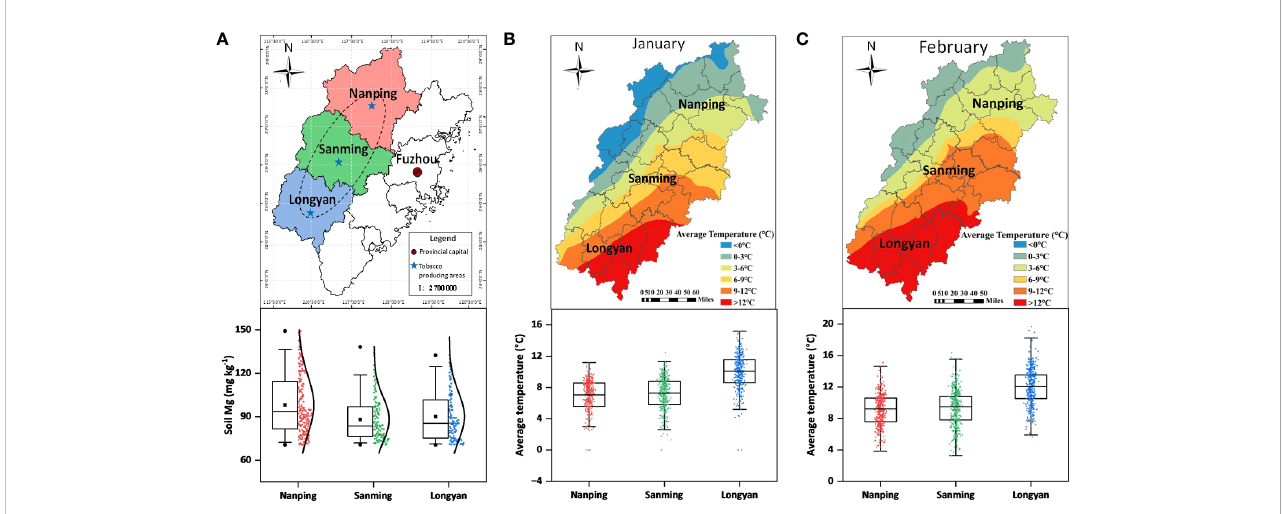
FIGURE 1 Map representing the geographic distribution of tobacco. (A) major fl ue-cured tobacco producing areas; (B, C) average temperature during the months of January and